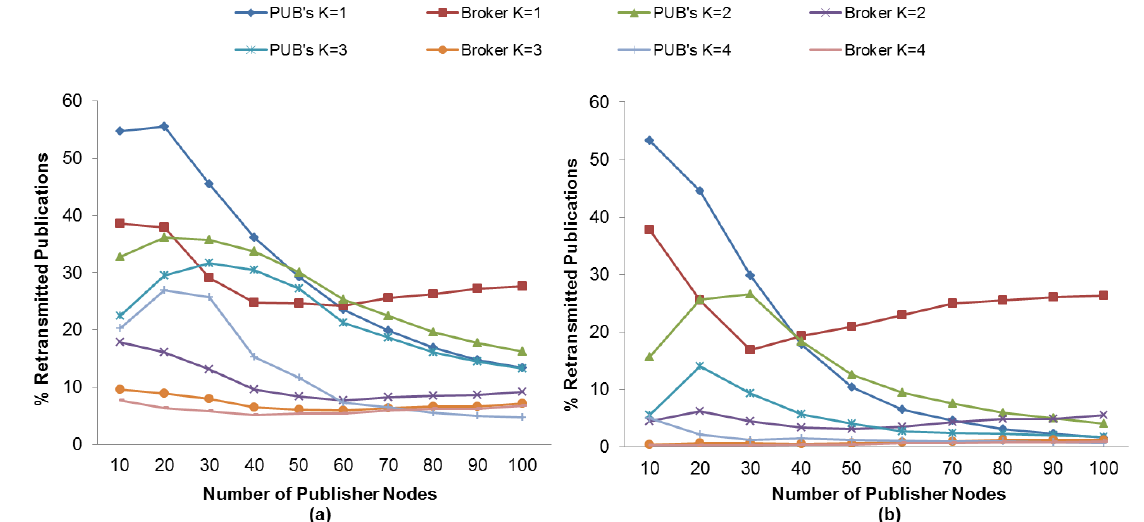
Figure 13. Effect of the number of Publisher nodes on publication messages retransmitted from Broker and Publisher Nodes using different K values without ( a ) and with ( b ) MAC